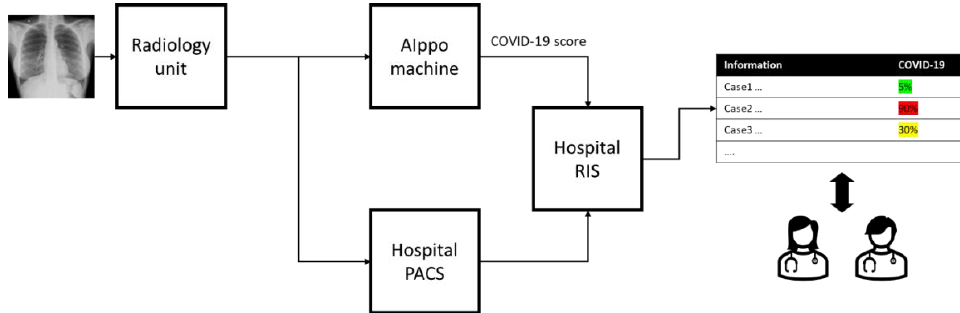
Figure 5. High level view on system installed at hospital for phase 2.